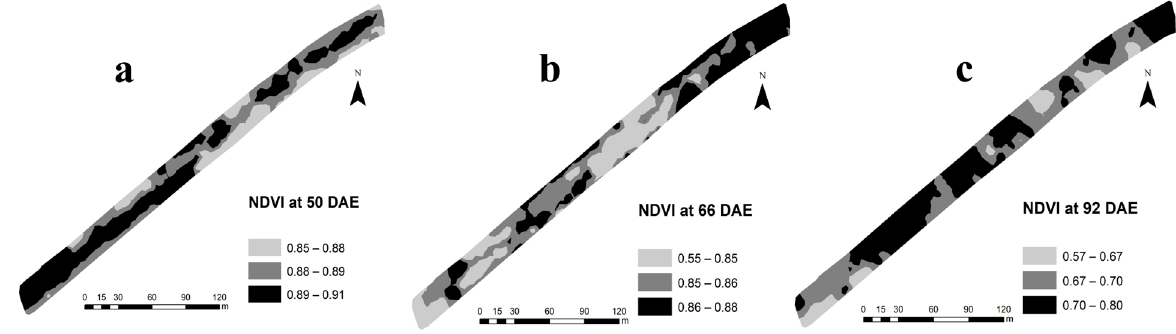
Figure 3. Spatial distribution of NDVI with five classes, according to the readings performed at 50 (a), 66 (b), and 92 DAE